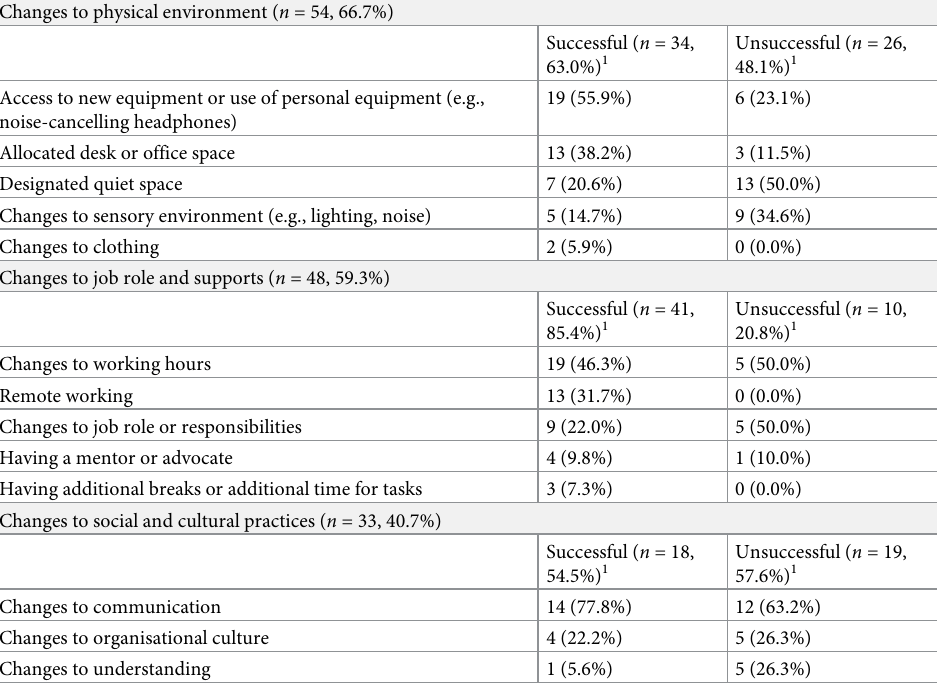
Successful ( n = 34, Unsuccessful ( n = 26, 48.1%) 1 63.0%) 1 19 (55.9%)